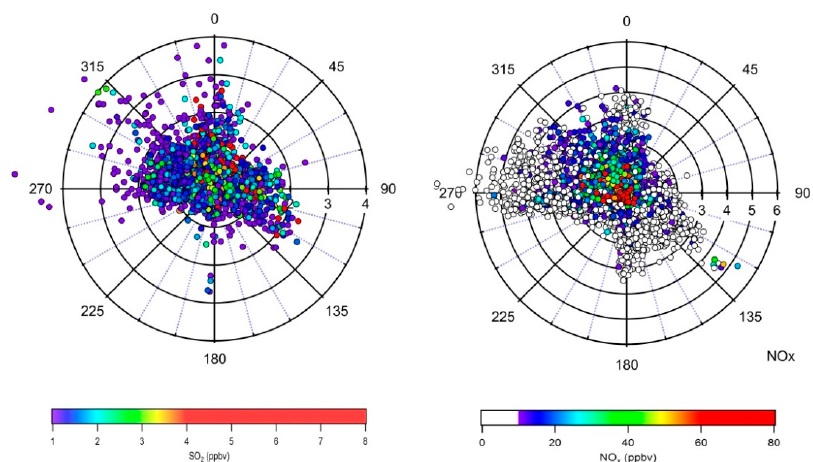
Figure A5. Polar bivariate plots for NH 3 (ppbv, top left panel), CO (ppbv, top right panel), SO 2 (ppbv, lower left panel) and NO x (ppbv, lower right panel) NH 3 and CO were measured by the OP-FTIR between October 2016 and September 2017. NO x and SO 2 were measured at the MAQ station between May 2016 and September 2017. For clarity, values close background (NH 3 < 2 ppbv, CO < 100 ppbv and SO 2 , NO x < 1 0 ppbv) are designated as white markers, SO 2 < 1ppbv removed and high values set to maximum colour designation (NH 3 > 5 ppbv, SO 2 > 4 ppbv, CO > 600 ppbv and NO x > 60 ppbv). The radial axis is the wind speed (CO, NH 3 and NO x : 0–6 m s − 1 ; and for clarity SO 2 0–4 m s − 1 ). Table A1. The ratio of the measured CO 2 to CO (ppbv) derived from the slope ( ± standard error of the estimate), the intercept ( ± standard error) and r 2 of the WODR regression. N is the number of points used in the regression. Summer CO 2 :CO ppmv:ppbv Intercept ppmv